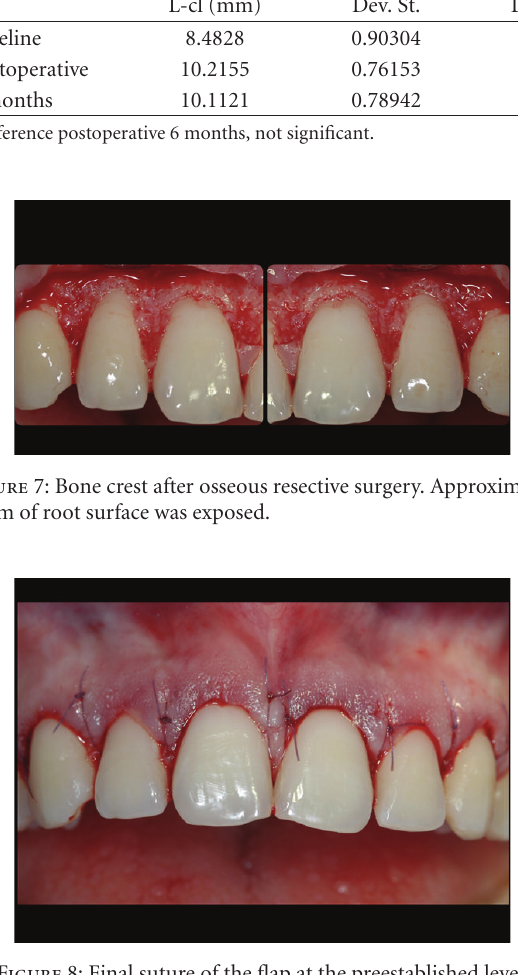
Figure 8: Final suture of the flap at the preestablished level.